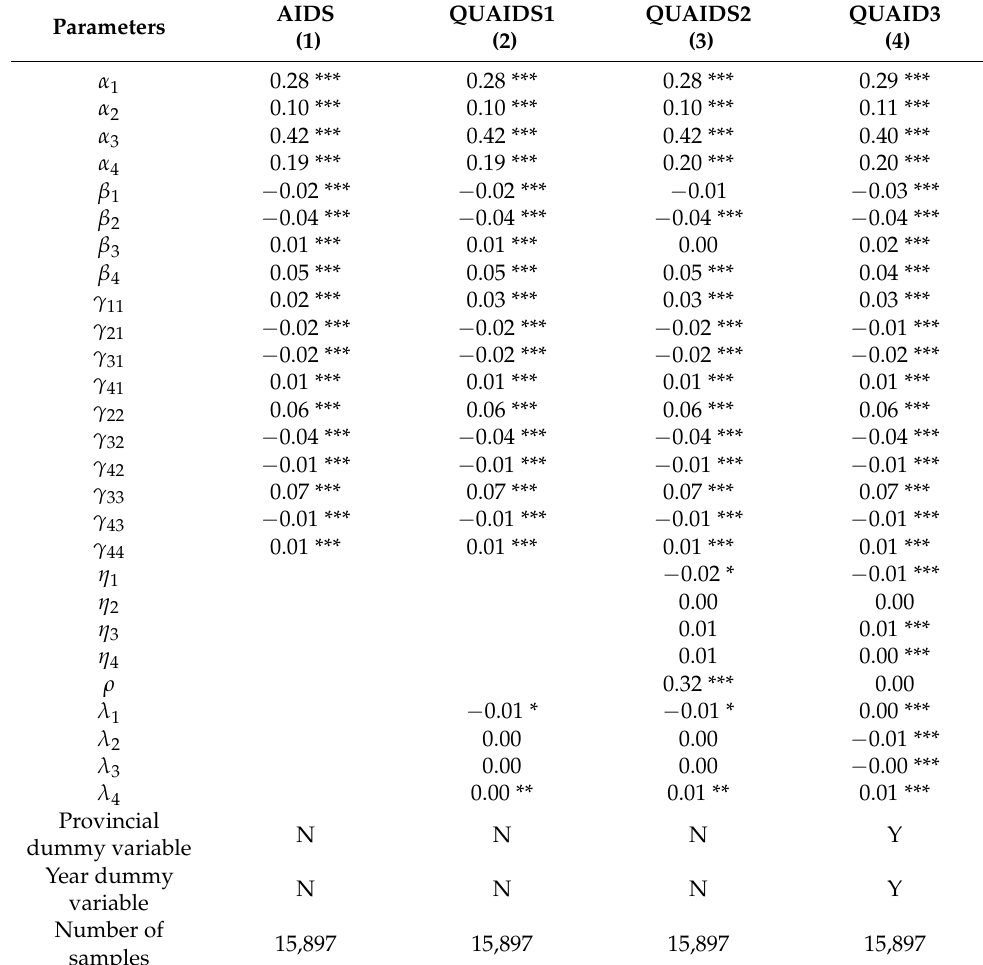
Table A3. Estimation results from the demand system model in the second stage.